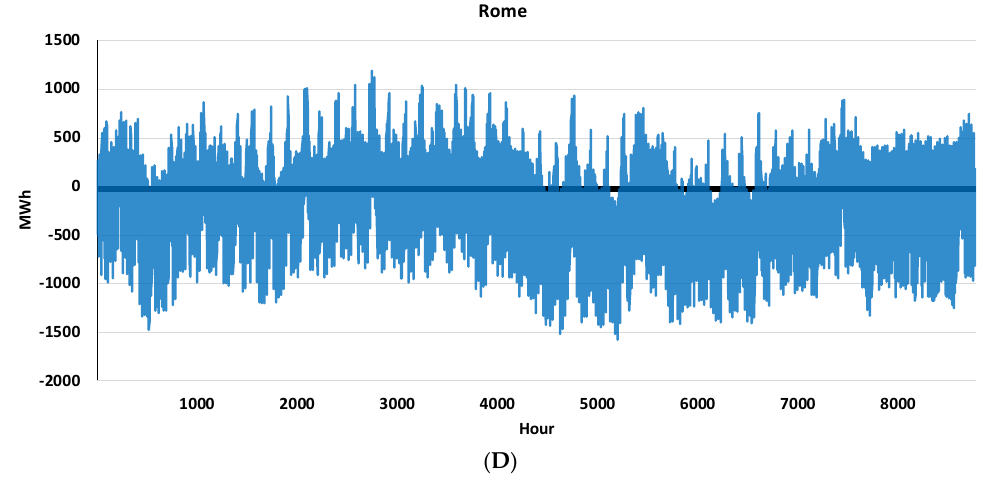
Figure 6. Electrical power production potential and consumption of ( A ) Umeå, ( B ) Stockholm, ( C ) Turin, ( D ) Rome.